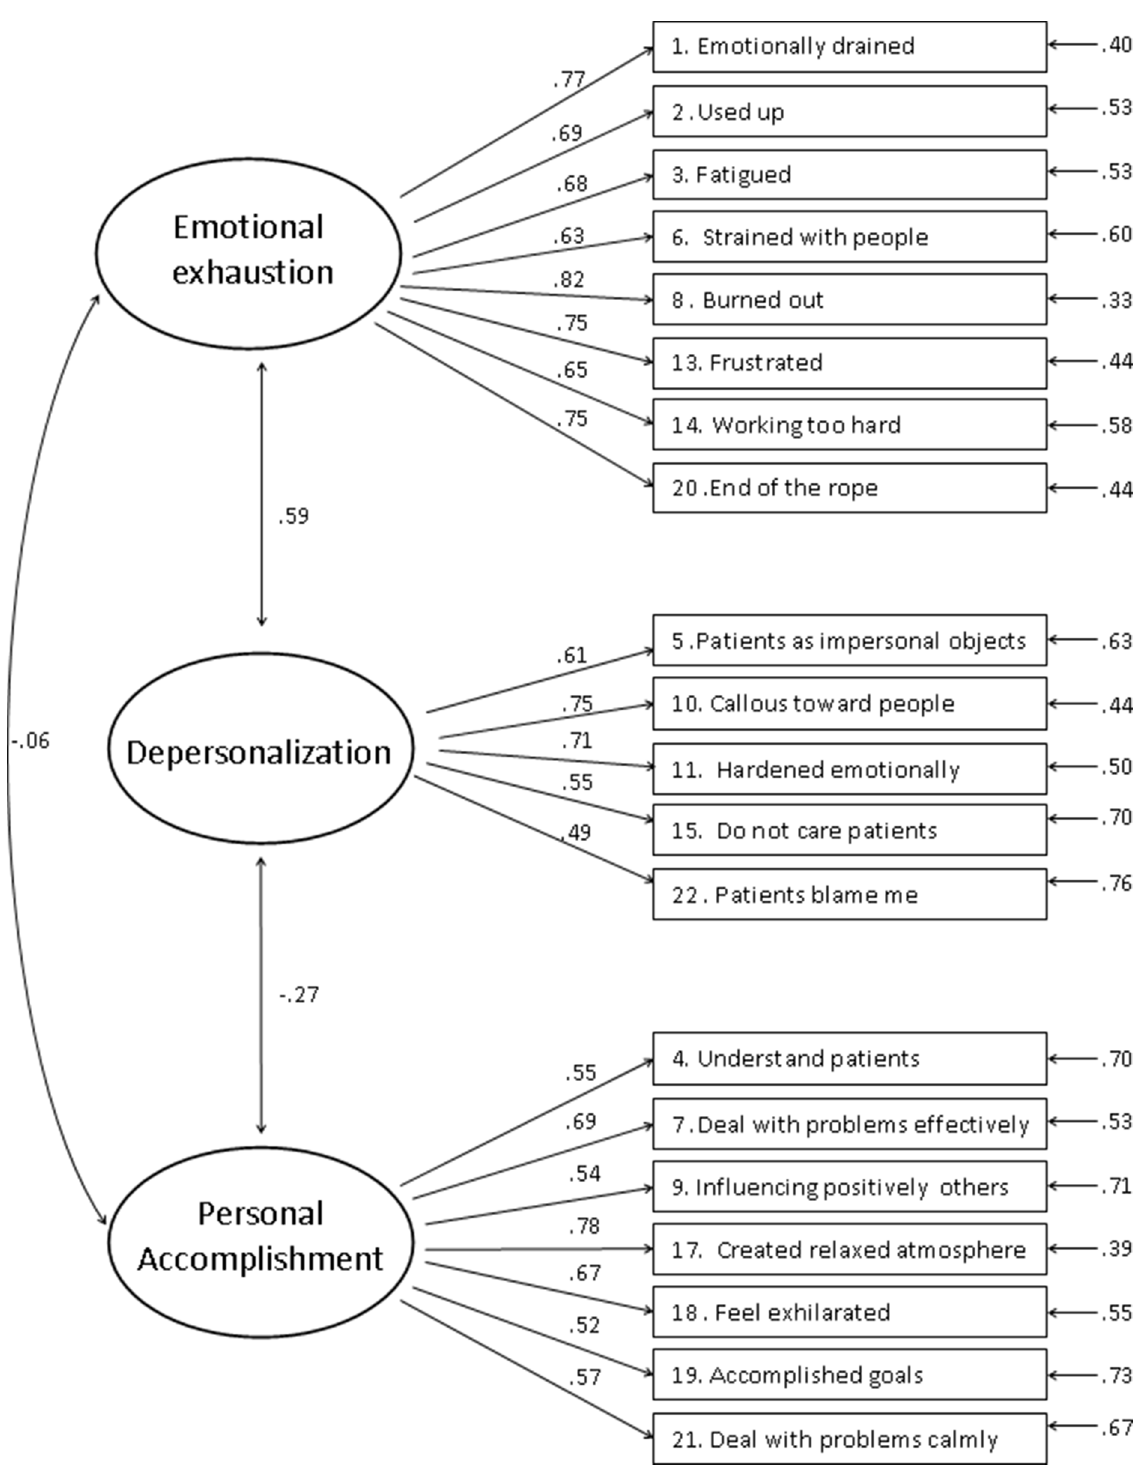
Fig. 1. Confirmatory Factor Analysis of Italian Version of the MBI-HSS (20 items, excluding 12 and 16).